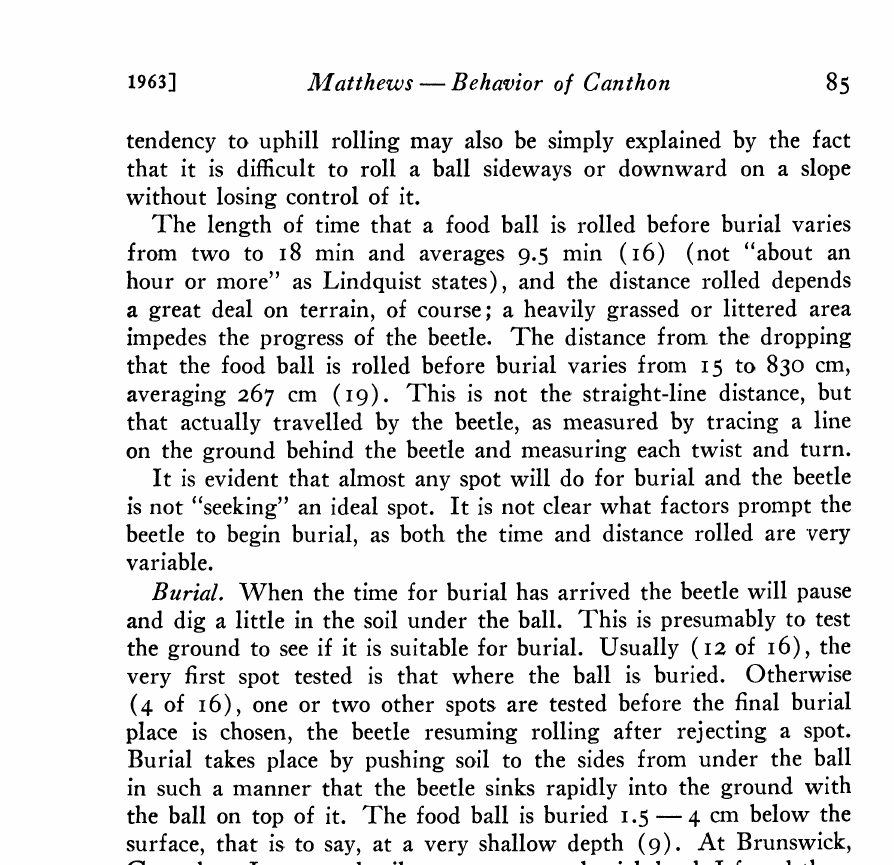
Figs. 6-10 represent the directions in which balls were seen rolled in relation to three different environmental factors in all localities, to the nearest 45 angle. Total of beetles observed is 70. Each dot represents one observation in the given direction. Chi-square and corresponding probability figures for three degrees of freedom are gbTen in each diagram. Further discussion in